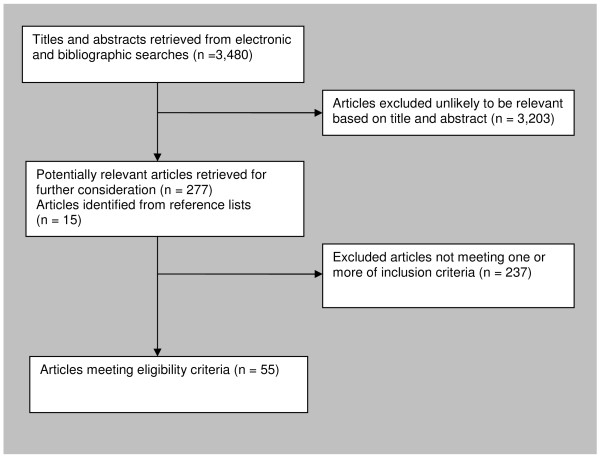
Results of literature search and selection of randomised controlled trials for systematic review.